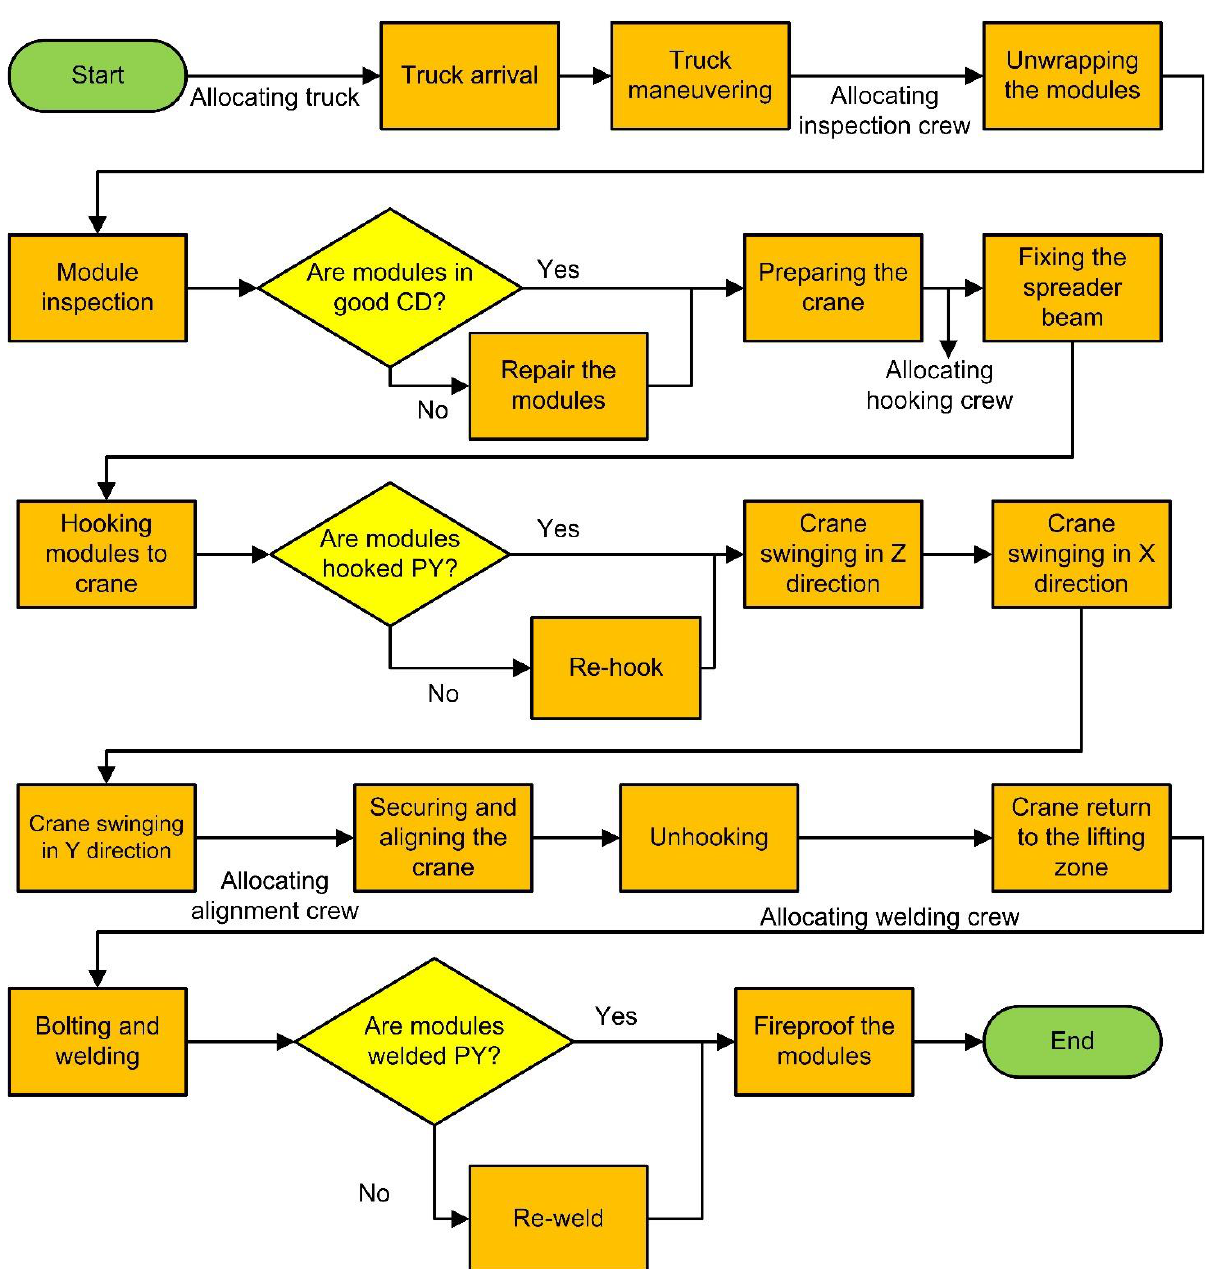
Figure 3. Flowchart of MiC installation processes.